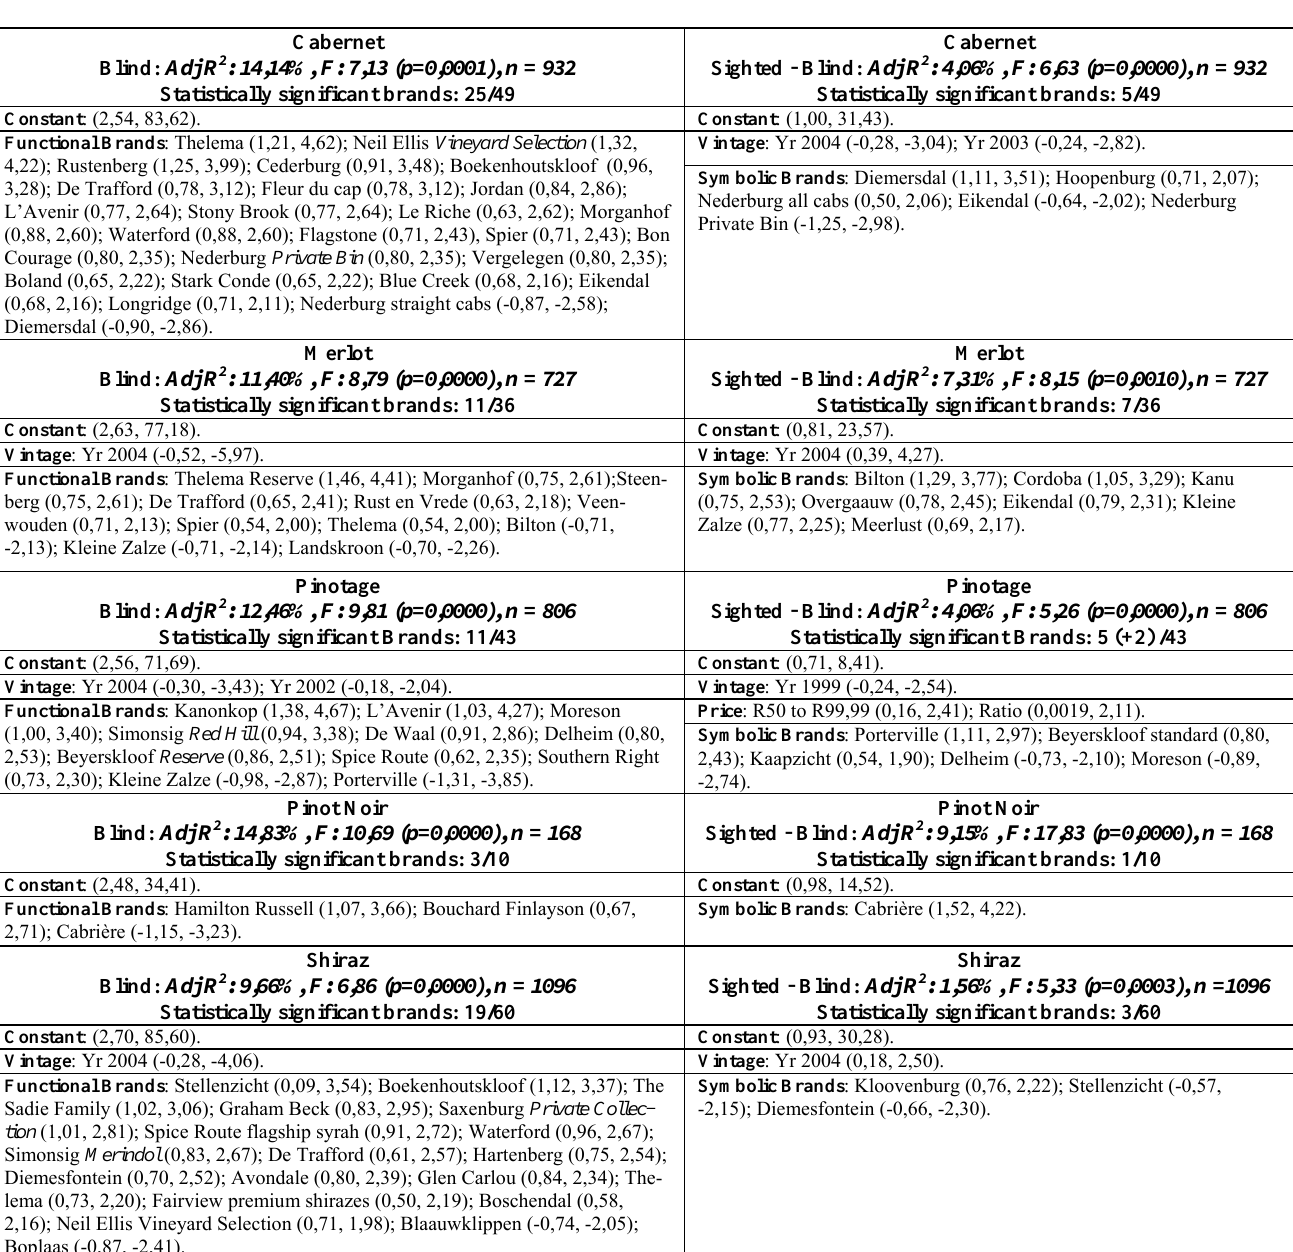
Table 9: Estimated red varietal regressions explaining blind and sighted minus blind wine assessments with controls for vintage and price. Where statistically significant at the 5% level, model variables appear, with their respective coefficients and t-statistics in parenthesis, in the sequence: constant, vintage, price (for symbolic effects), and brand. Each variable is sorted by order of t -stat. (Note that with price effects an additional two pinotage and six red blend symbolic brands are identified.)